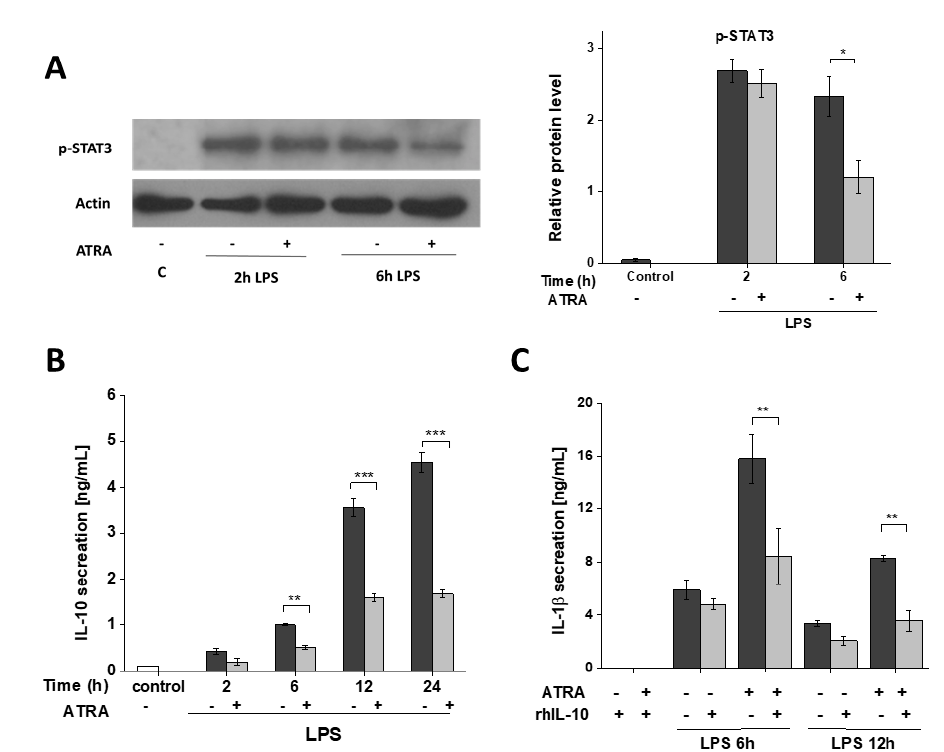
Figure 6. ATRA modulates LPS-induced IL-10 secretion and STAT3 activation in M Φ s. M Φ s were pre- incubated with ATRA (1 µM) prior to stimulation with LPS (100 ng/mL) for the indicated time. ( A ) Representative immunoblots of phosphorylated STAT3 from whole-cell lysates. β -actin was used as the internal control. ( B ) The secretion of IL-10 was assessed by ELISA from cell culture supernatants. ( C ) The cells were pre-treated with recombinant human IL-10 (rhIL-10) (100 ng/mL) 1 h before LPS priming and subsequently incubated with ATP (5 mM) for 45 min. Then, the cell culture supernatants were collected, and the secretion of IL-1 β was assessed by ELISA. C, control (mock-treated cells). The data were obtained from at least four healthy donors. All results are shown as means ± SEM. (* p < 0.05, ** p < 0.001, *** p < 0.001). +, − , presence or absence of indicated substance, respectively